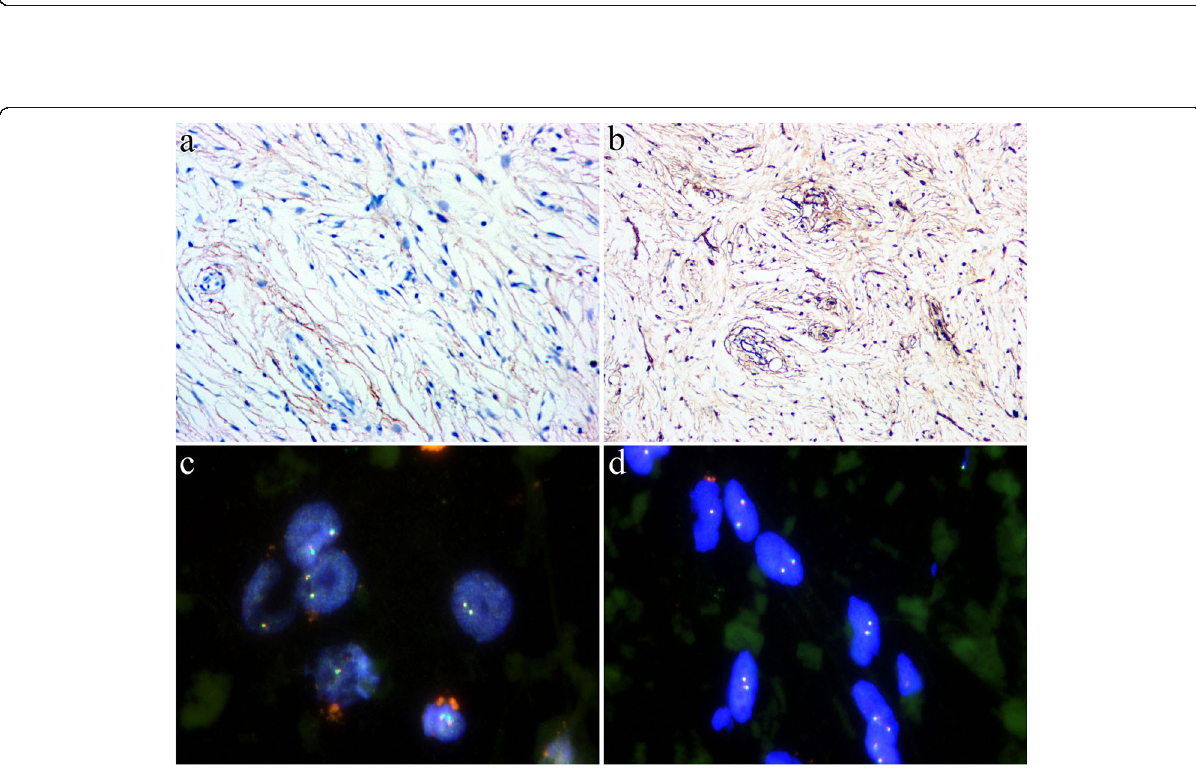
Fig. 6 The tumor cells exhibited diffuse and weak expression of EMA ( A ) and CD34 ( B ). In FISH analyses, the tumor cells were negative for rearrangements of EWSR1 ( C , red signals: 5 ’ of EWSR1; green signals: 3 ’ of EWSR1 ) and KMT2A ( D , red signals: 5 ’ of KMT2A; green signals: 3 ’ of KMT2A